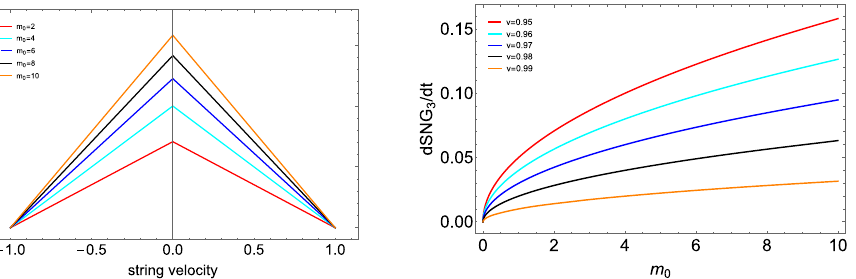
Fig. 1 Left: action growth v.s. string velocity in BTZ black hole for different m 0 . Right: action growth v.s. black hole mass in BTZ black hole for different string